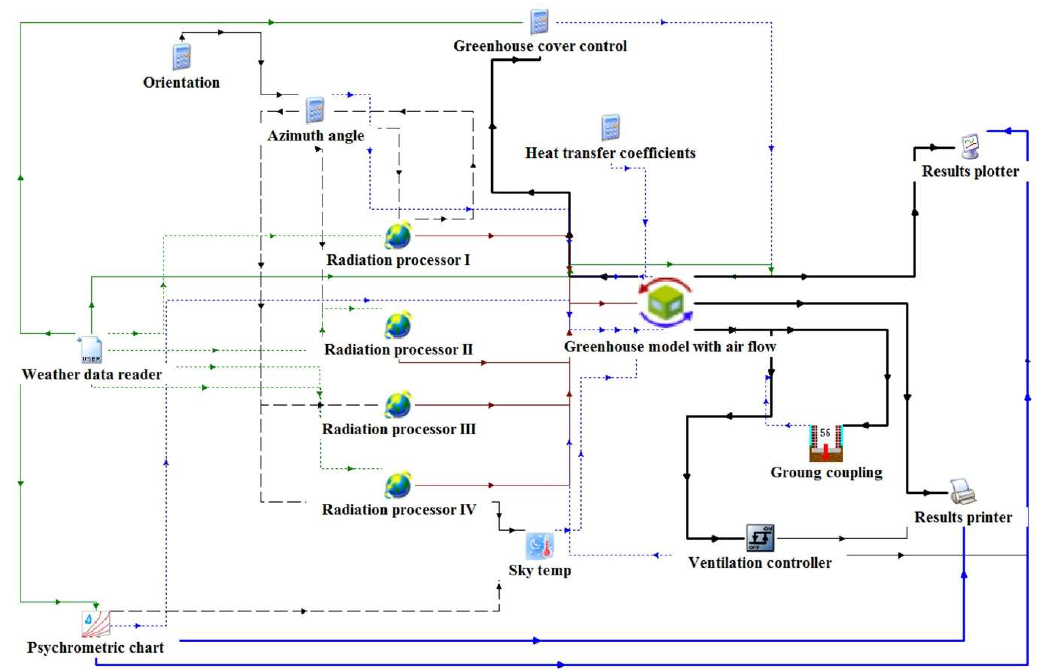
Figure 8. TRNSYS Simulation Studio greenhouse model. Table 5. Components of the greenhouse model in TRNSYS 18.